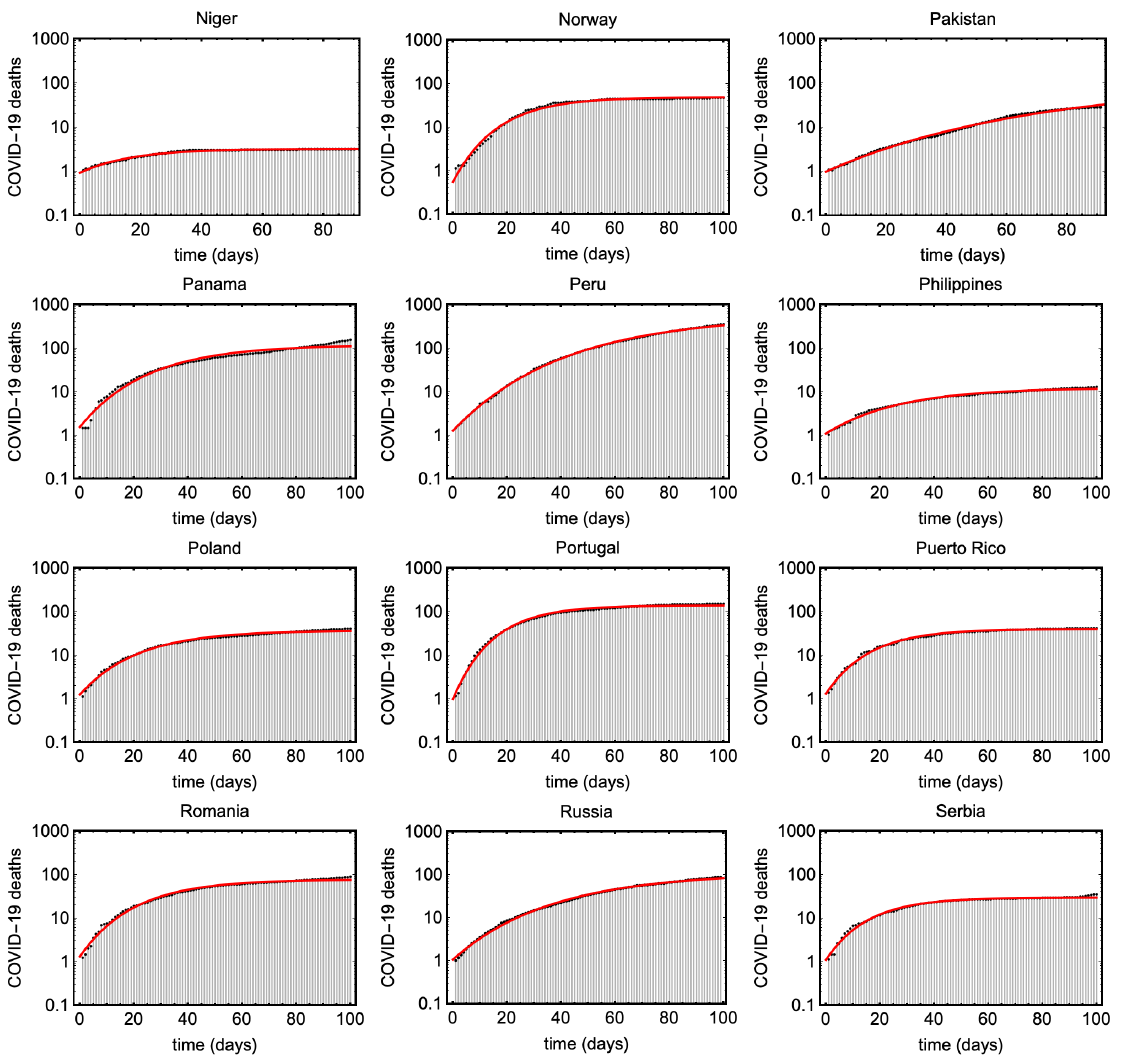
Figure A6. Shows cumulative COVID19 deaths (black) and the estimated Gompertz curves for different countries